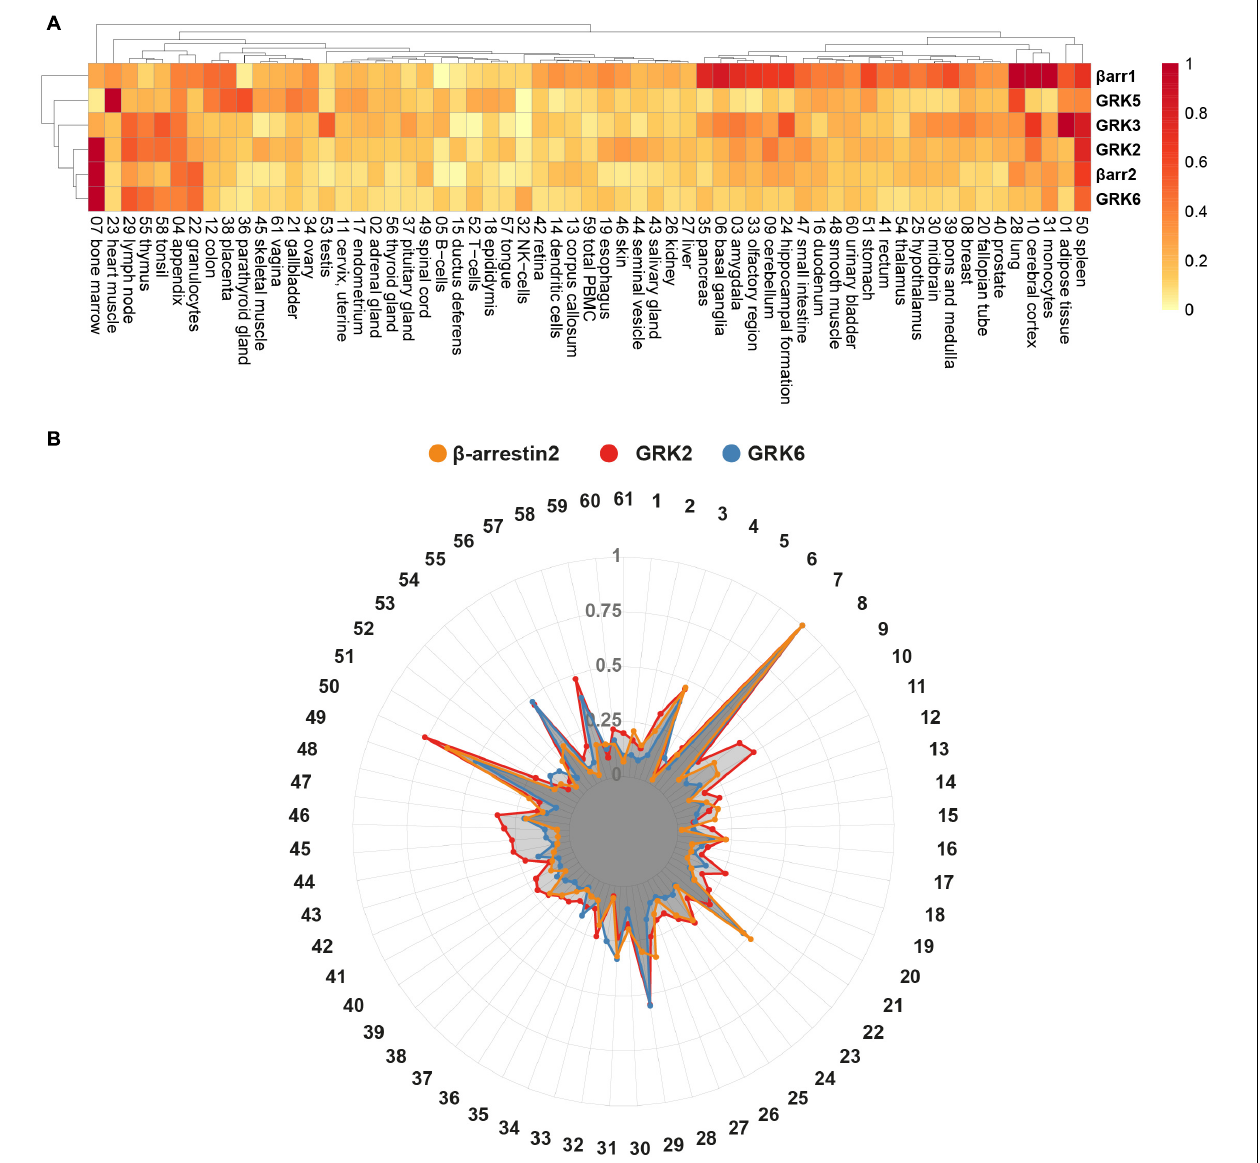
FIGURE 4 | Clustering of relative protein expression and overlay of GRK2, GRK6, and β -arrestin2 tissue expression. (A) Clustering of relative expression profiles of GRK2, 3, 5, 6, and β -arrestin1 and 2, according to Euclidean distance. The NX values of Table 1 were normalized to the respective maximal tissue expression for each protein. The clustering heatmap was generated using the pheatmap R package (Kolde (2013). pheatmap: Pretty Heatmaps. R package version 1.0.12, http://CRAN.R-project.org/package=pheatmap). (B) Relative tissue expression of GRK2 (red), GRK6 (blue), and β -arrestin2 (yellow) are shown together. The data are based on the Human Protein Atlas version 20.1 (https://www.proteinatlas.org/), last accessed March 10th,